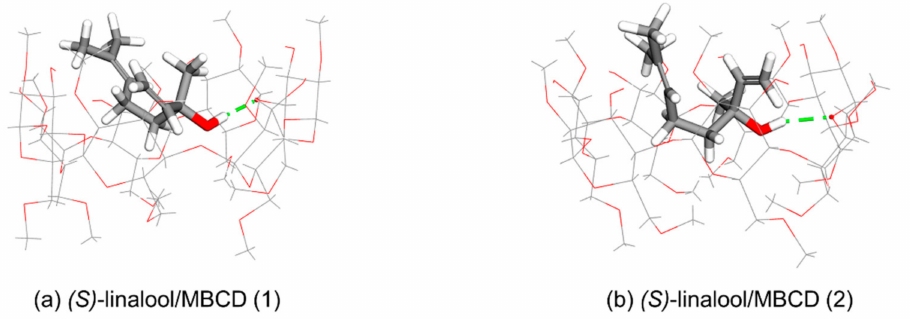
Figure 9. Energy-minimized structure of the 1:1 ( S )-linalool/MBCD complexes from two clusters using PM7 method. MBCD is presented as a line model. The linalool molecule is presented as a stick model. The green dashed line refers to hydrogen